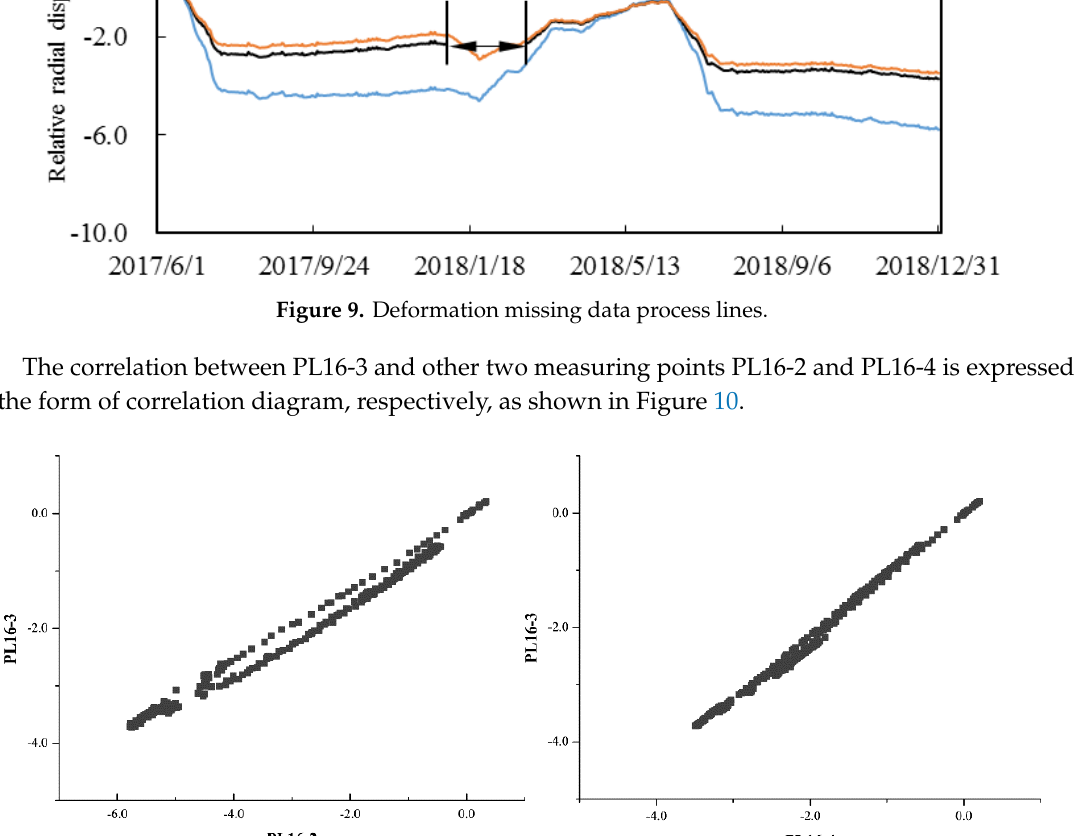
Table 5. Accuracy of the two estimation methods.